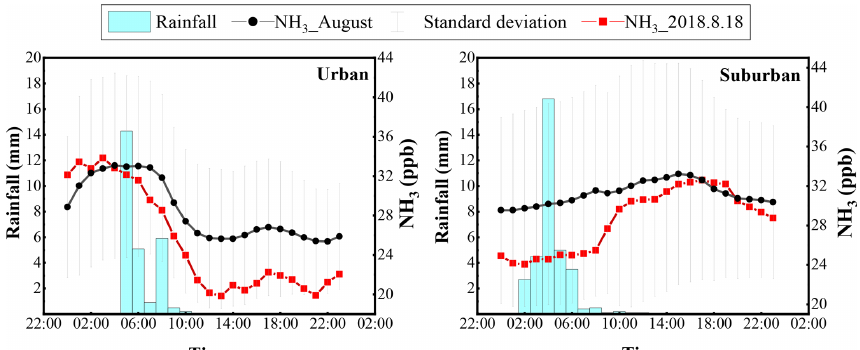
Figure 8. Diurnal variations in the rainfall and NH 3 concentration on 18 August 2018.